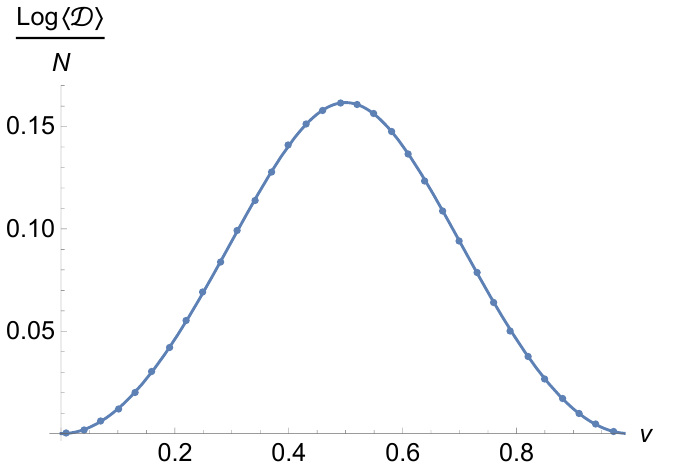
Figure 4. Defect expectation value in d = 3 critical theory at leading order in large N . Solid line interpolates the numerical results.